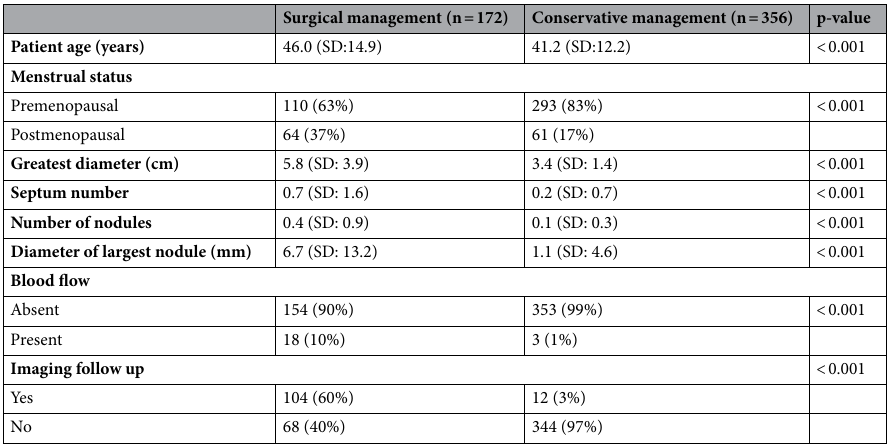
Table 2. Imaging and clinical characteristics of surgically vs. conservatively managed masses. Of the 528 consecutive ultrasound studies of adnexal masses included, 172 ultimately went to surgery and 354 were followed with imaging and/or physical exam until resolution or stability. Patient and imaging characteristics compared above using Chi-square and t-test for categorical and continuous variables respectively. Of note, ‘septum number’ and ‘number of nodules’ were not evenly distributed, and the median values for both surgically and conservatively managed lesions in these categories are all zero. Mean values are provided within the table to provide a non-zero comparison between groups.